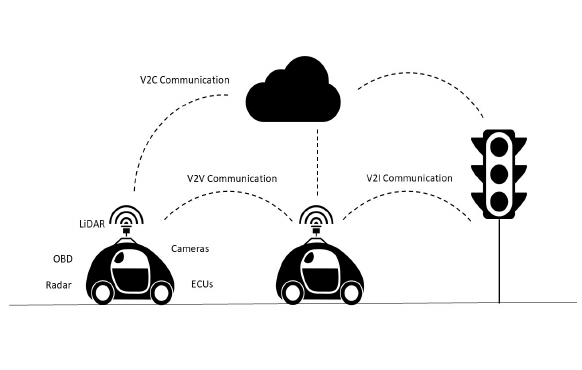
Figure 3. Attack points through